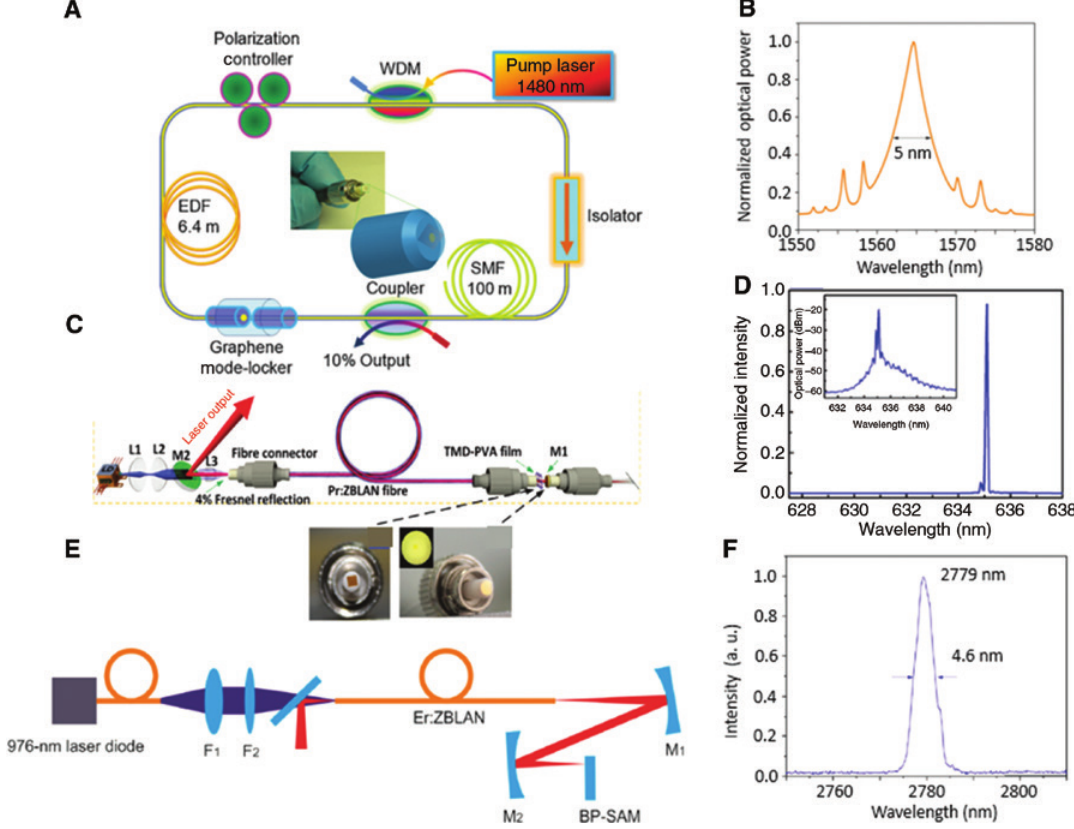
Figure 3: Typical ultrafast fiber laser system using 2D materials as saturable absorbers. (A and B) Schematic diagram of typical fiber laser with atomic layer graphene as saturable absorber and its output spectrum operating at the telecommunication band [64]. (C and D) Typical fiber laser system utilizing TMDs as saturable absorber operating at visible range and its output spectrum [92]. (E and F) Q-switched fiber laser system operating at far mid-infrared spectral range utilizing black phosphorus as saturable absorber and its output spectrum [93]. (A and B) Reproduced with permission [64]. Copyright 2009, WILEY-VCH. (C and D) Reproduced with permission [92]. Copyright 2016, The Royal Society of Chemistry. (E and F) Reproduced with permission [93]. Copyright 2015, Optical Society of